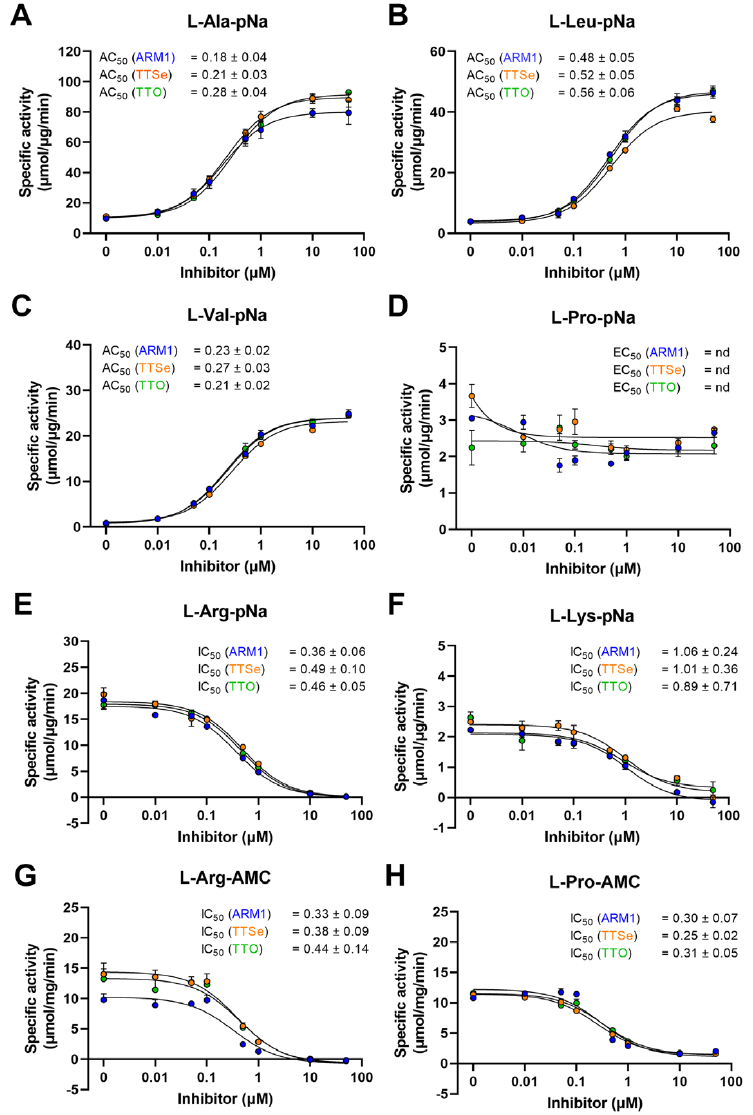
Figure 4. Effect of chalcogen-containing inhibitors on the peptidase activity of LTA 4 H. ( A – C ) Specific activities of LTA 4 H determined with hydrophobic pNa conjugates; ( D ) The specific activity with L-Proline-pNa; ( E , F ) Activity measurements with substrates containing positively charged longer residues; ( G , H ) The IC 50 values determined with AMC